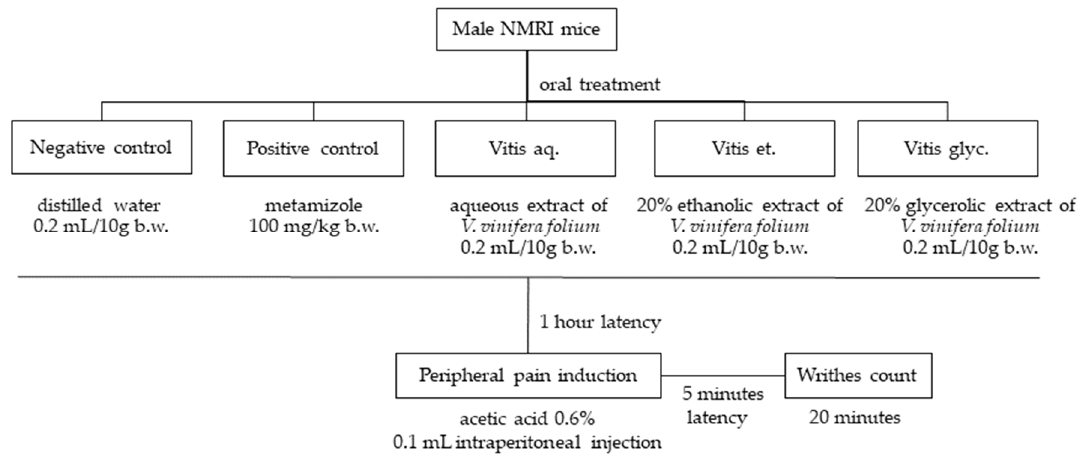
Figure 1. Experimental protocol for antinociception evaluation. Vitis aq.: Vitis vinifera aqueous extract; Vitis et.: V. vinifiera 20% ethanolic extract; Vitis glyc.: V. vinifera 20% glycerolic extract; b.w.: body weight.